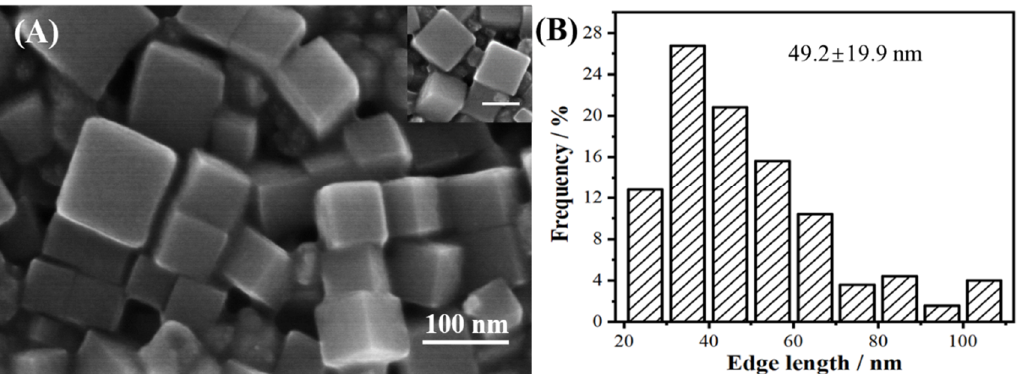
Figure 1. ( A ) Overview SEM image of the Pd nanocubes prepared using the standard synthesis. The inset shows the high-magnification SEM image of the Pd nanocubes, with a scale bar of 100 nm. ( B ) Histogram of edge-length of the Pd nanocubes.